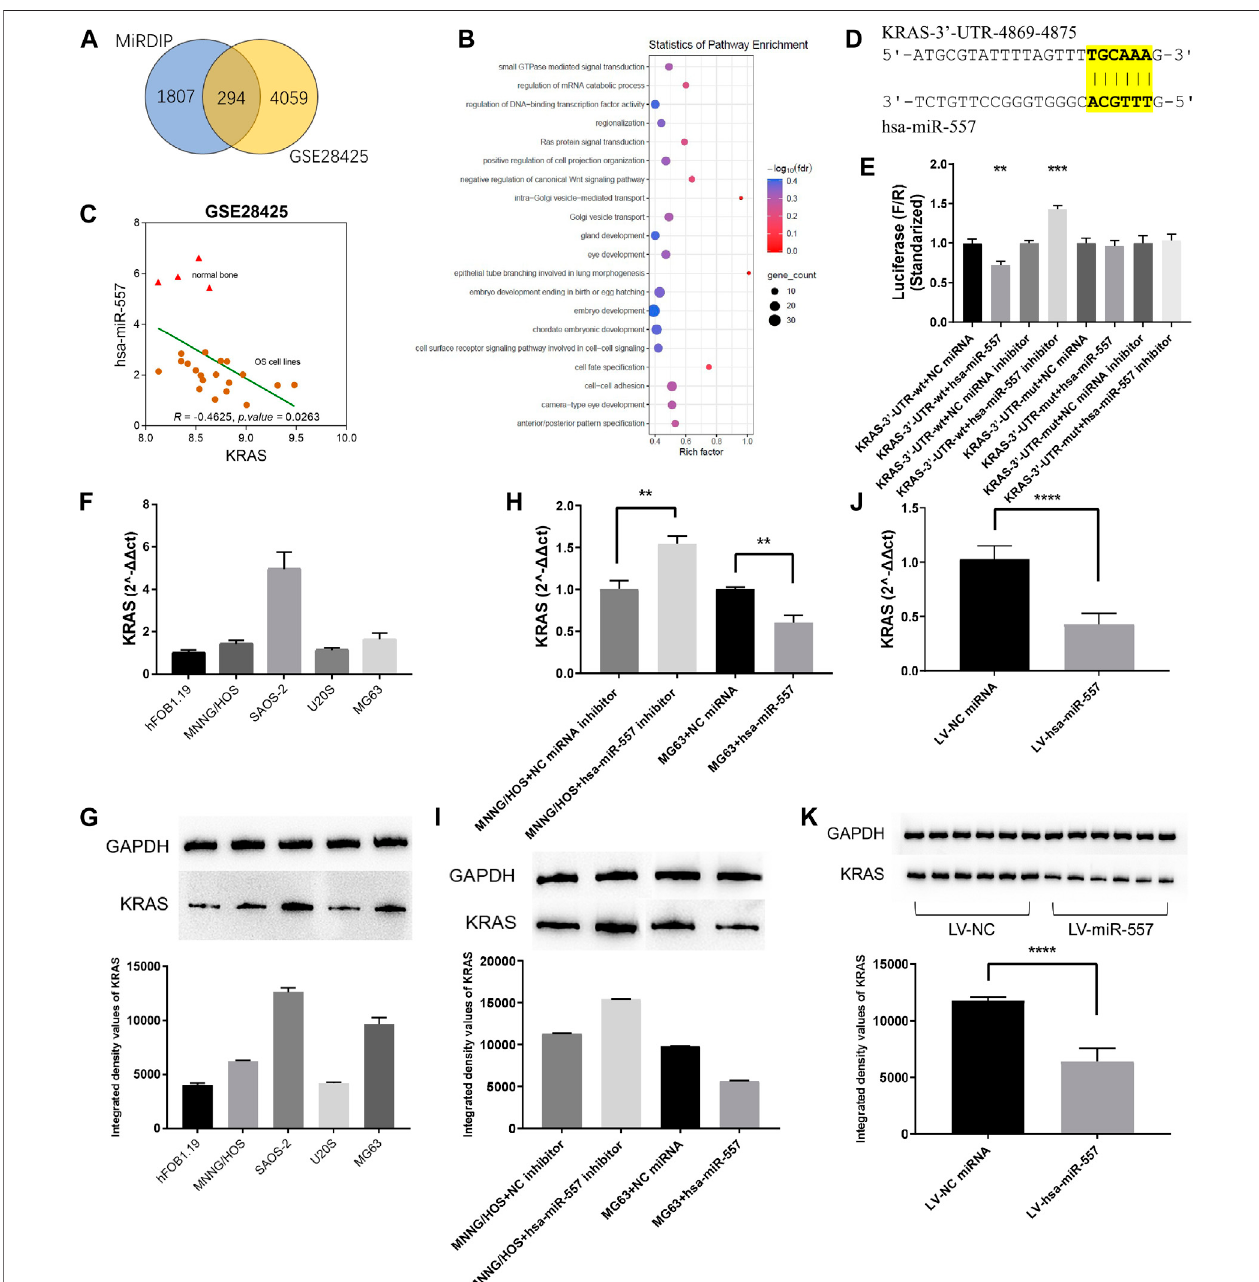
FIGURE4| Hsa-miR-557inhibitedthegrowthofosteosarcomathroughKRAS. (A) CombingtheGSE28425datasetwiththemiRDIPdatabase,294hsa-miR-557 targetgeneswerefoundtobesigni fi cantlydownregulated. (B) PathwayenrichmentusingSTRINGshowedthattheRASsignalingpathwaywassigni fi cantlyinvolved. (C) Data from GSE28425 showed a signi fi cant negative correlation between KRAS and hsa-miR-557. (D) Simulation of hsa-miR-557 target sequence of KRAS 3 ′ UTR. (E) Dual-luciferasereporterassayshowedthatlowerlevelsofF/RweredetectedintheKRAS-3 ′ UTR-wt+hsa-miR-557group,andhigherlevelsofF/Rweredetected in the KRAS-3 ′ UTR-wt + hsa-miR-557 inhibitor group. (F,G) Expression level of KRAS in osteosarcoma cell lines (MNNG/HOS, SAOS-2, U20S, and MG63) and normal osteoblasts (hFOB1.19). (H,I) Levels of KRAS were inhibited by hsa-miR-557 in MG63 cells and promoted by hsa-miR-557 inhibitor in MNNG/HOS cells. (J,K) In the nude mice model, lower levels of KRAS expression were tested in the hsa-miR-557 vector group (** p < 0.01, **** p < 0.0001).